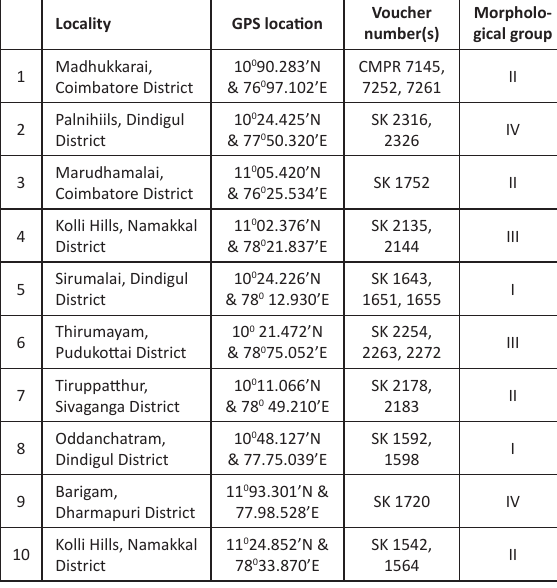
Table 1. Localities and morphological variants of Caralluma adscendens var. attenuata (Wight) Grav. & Mayur. in Tamil